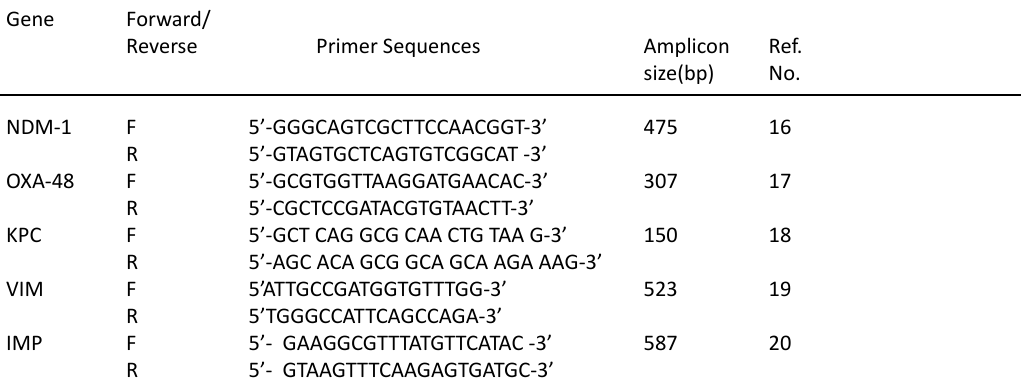
table 2. PCR programs used for standardization of